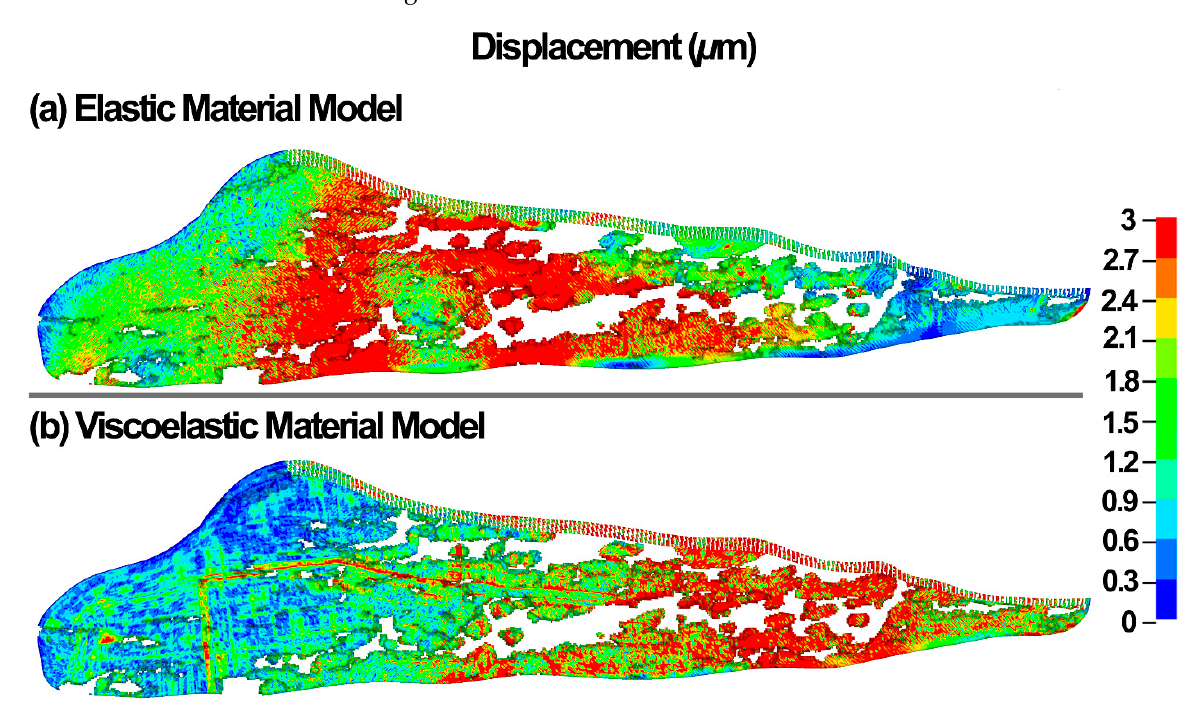
Figure 8. The displacement in the TM/JCT/SC complex with ( a ) elastic and ( b ) viscoelastic material model at the IOP of 10 mmHg. Table 1. Volumetric average stresses and strains in the TM/JCT/SC complex and volumetric average pressure in the aqueous humor.